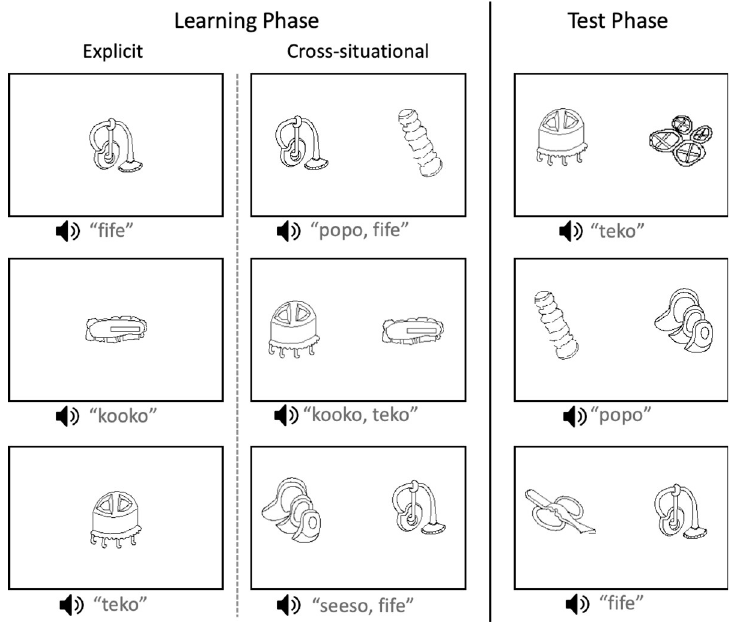
Fig 2. Examples of learning phase and test phase trials for Experiment 1. Participants completed either the explicit word learning or XSWL training